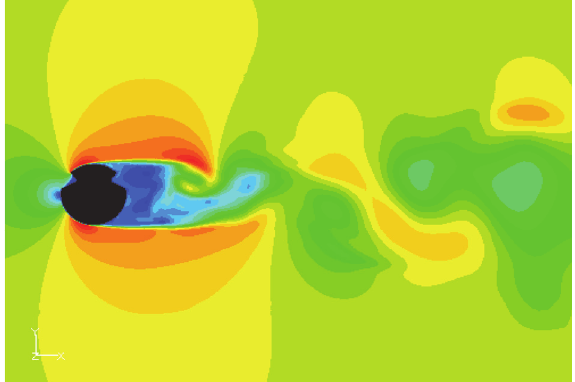
Figure 5: Nephogram of the flow velocity around the contact wire cross section in CFD